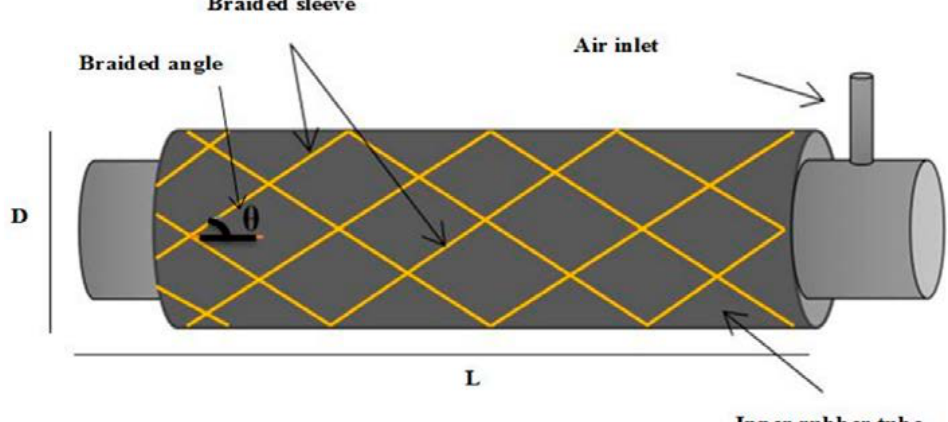
Figure 18. Diagram of pneumatic artificial muscle with components labeled, D is the width of the overall sleeve assembly, L is the overall length of the assembly, θ is the braided angle (Reprinted with permission from Al-Ibadi, A., et al. [145]. Copyright 2018, CC BY 4.0 International).